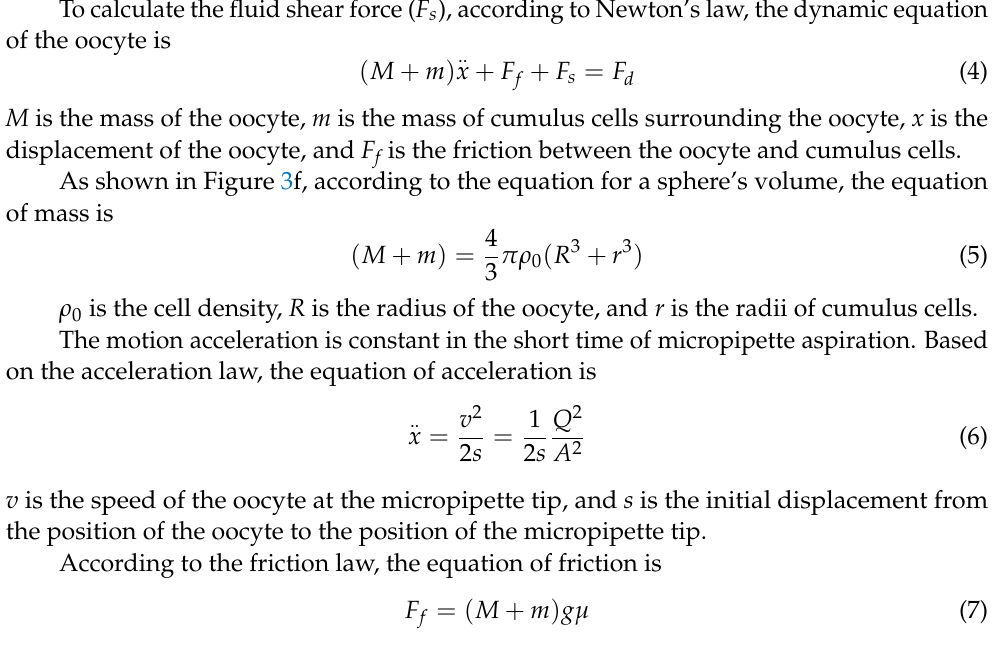
To calculate the fluid shear force ( F s ), according to Newton’s law, the dynamic equation of the oocyte